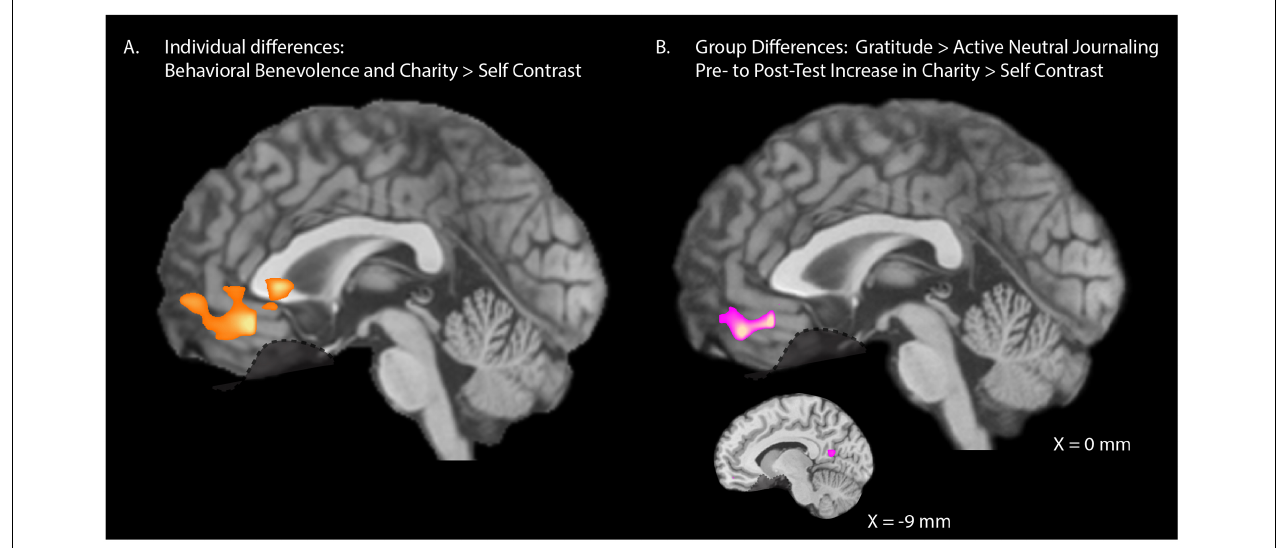
FIGURE 5 | Whole-brain analyses. (A) Individual differences: Exploratory whole-brain analyses for the relationship between pre-test levels of behavioral benevolence and neural pure altruism. Behavioral benevolence is defined as an aggregate across self-reported gratitude, self-reported-altruism, and satisfaction with costly donations. Neural pure altruism, is defined as the contrast between mandatory charity-gains and mandatory self-gains [shown here at T (30) > 3.64, p < 0.001 2-tailed with a 53 voxel cluster correction threshold corresponding to family wise error rate (FWE) p < 0.05]. One VMPFC cluster survived correction [XYZ = (0, 36, –12), K = 173, max = 5.4, mean = 4.1]. (B) Intervention Effects: Exploratory whole-brain analyses for pre- to post-test change in neural pure altruism for the gratitude-journaling group versus the active-neutral journaling control group shown at a liberal threshold of T (29) > 2.76, p < 0.01 2-tail uncorrected, K > 20 yielding one VMPFC cluster [XYZ = (0, 45, –18), K = 56, max = 3.64, mean = 3.1] and one left precuneus cluster [XYZ = (–9, –60, 12), K = 21, max = 3.62, mean =